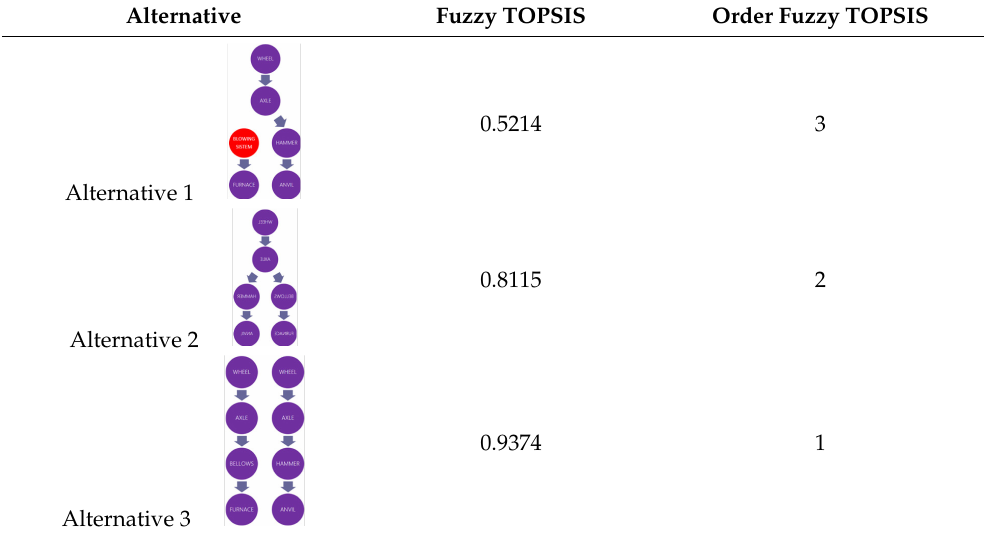
Figure 12. Current state of the water body and graphical reconstruction developed in this work. Source: own elaboration. Table 5. Alternative evaluation: Fuzzy TOPSIS